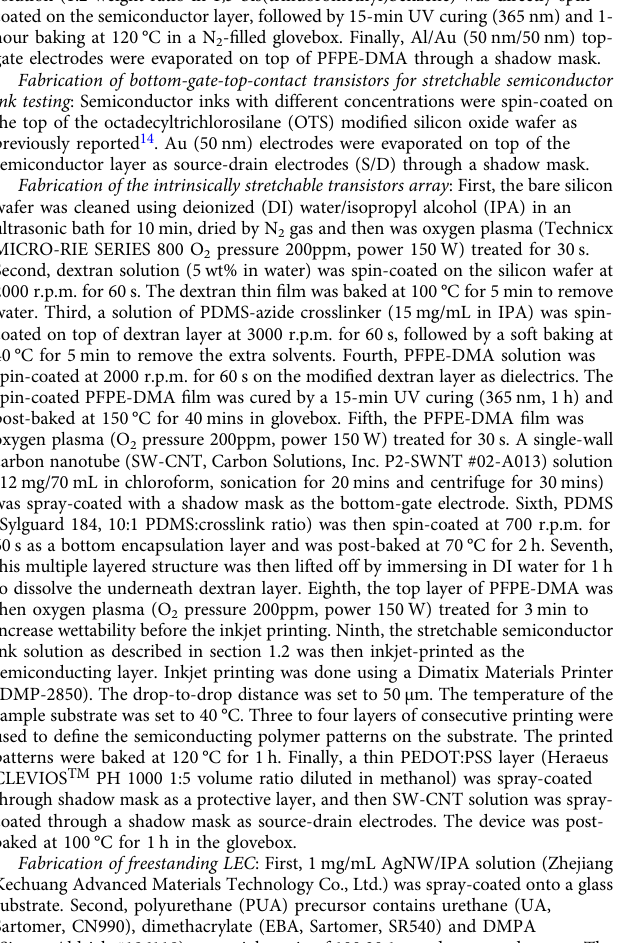
Fig. 4 Fully stretchable AMOLEC array. a Schematic of the stretchable light-emitting electrochemical cell (LEC). Yellow highlighted schematics show the molecular structure of stretchable ion-conducting polymer and super yellow (SY) used to enable the stretchable, tissue-level soft LEC. b Strain tolerance and light-emitting intensity ratio (light-emitting intensity/initial light-emitting intensity, L/L 0 ) of LEC to the different weight ratios of ionic polymer to SY. c Representative curve of current density as a function of the voltage of the stretchable LEC with 1:1 weight ratio of stretchable polymer: SY. It shows a stable current density as a function of strain (inset). The active area of the device is 2 × 3 mm 2 . The “ on ” state of the LEC is de fi ned as current density above 2 mA/cm 2 as chosen by curves in c . d Schematic 3D layout of individual stretchable LEC pixel driven by a stretchable OTFT. e Drain current and the corresponding current density of the fully stretchable OTFT subjected to strains from 0 to 30%. Values are mean ± S.D. f The on-off-current from the transistor controlled by the gate voltage and the representative images of LEC at “ off ” and “ on ” states. g Photographic image of a stretchable LEC pixel turned-on by the vertically integrated stretchable transistor. h Photographic images of a single LEC pixel subjected to different strains. i Schematic of the vertical integrated active matrix and LEC array. j The histogram of drain-currents from a typical stretchable OTFT active matrix. k A SEM cross-sectional image of an AMOLEC device stack after subjected to 30% strain and released. The false colour highlights the active layer of OTFT (red) and LEC (yellow), respectively. l Photographic images of the AMOLEC skin display pixels with different columns being selectively turned on. m Photographic images of AMOLEC skin display pixels subjected to both bending, twisting